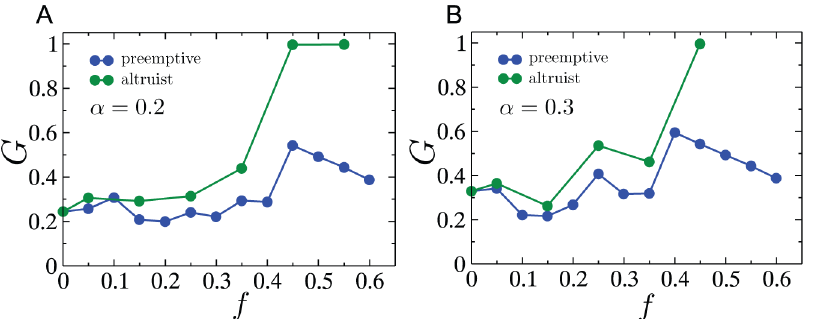
Figure 14. Cascade mitigation on the UCTE network. Comparison between the preemptive and altruistic node removal strategies on the UCTE network with tolerance parameter (A) a ~ 0 : 2 and (B) a ~ 0 : 3 .